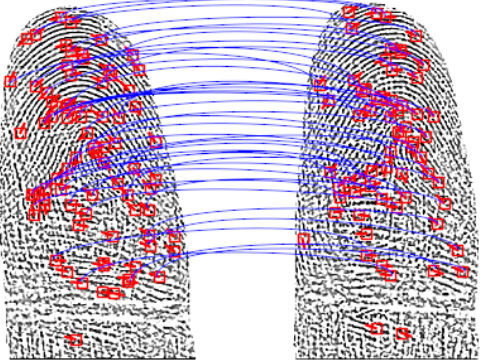
Figure 18. Illustration of a minutiae-based comparison of two contactless fingerprint samples. The fea- tures are extracted using the method described in Section 4. The blue lines indicate mated